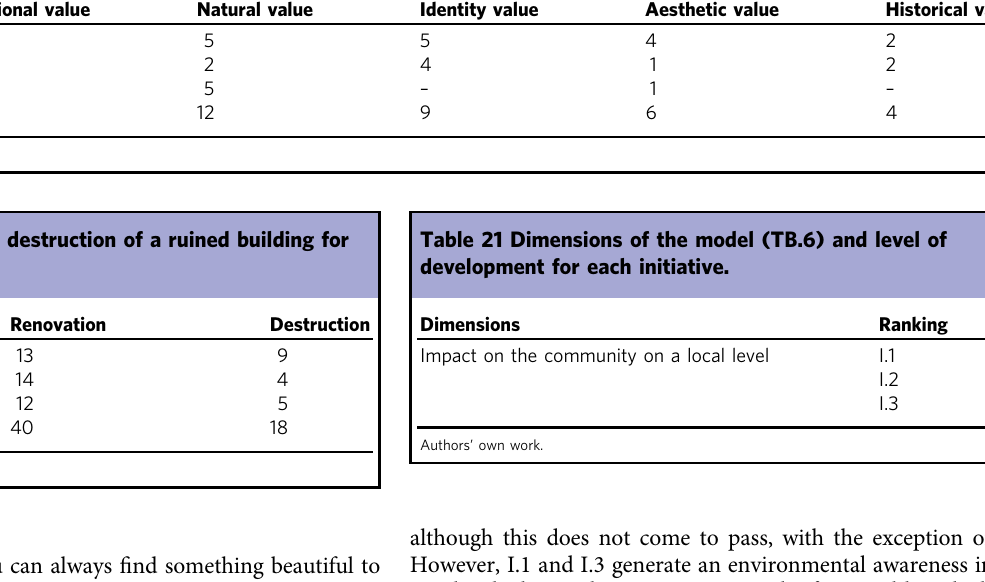
Table 19 Value given to landscape.